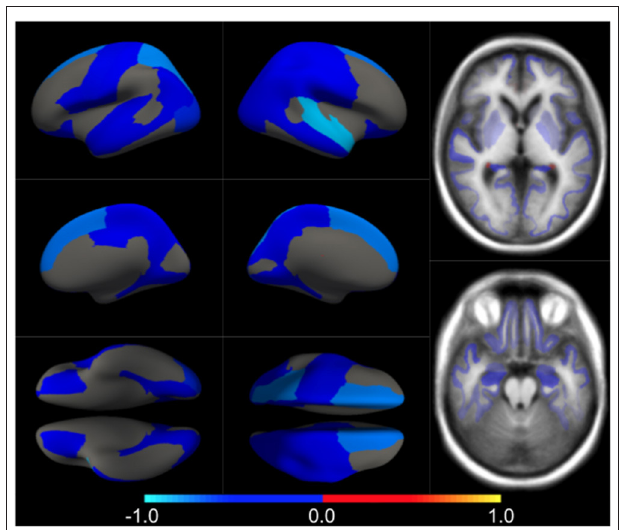
FIGURE 1 | Different views of the multivariate brain morphometric effect of age (type v cAD ). For visualization purposes, we have scaled the effect-type in the range [ 1, 1] and masked all regions below a certain threshold (20% of the − maximum value). The color-code represents negative (blue) and positive (red) relative contributions of each brain ROI to explaining the variability of confounders (age and